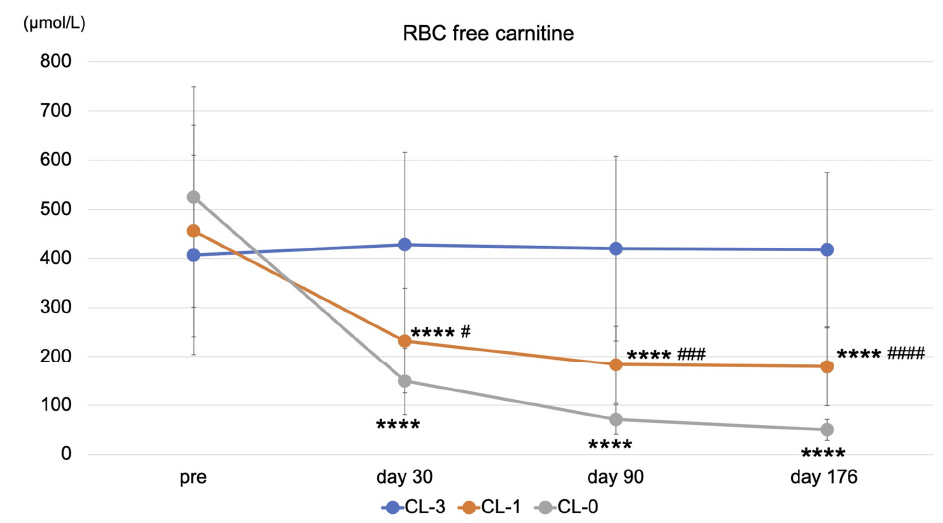
Figure 4. Kinetics of RBC-free carnitine level during the study. LC-3: LC 1000 mg three times weekly; LC-1: LC 1000 mg once and placebo (saline 5 mL) twice weekly; LC-0: placebo three times weekly (LC-0). **** p < 0.0001 vs. LC-3; # p < 0.05; ### p < 0.001; #### p < 0.0001 vs. LC-0.